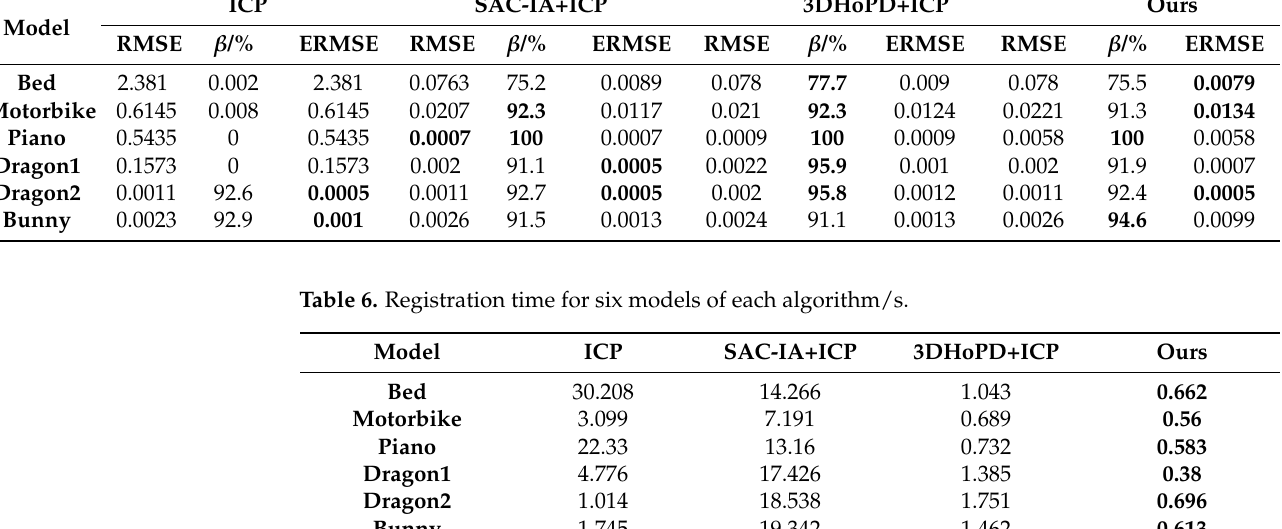
Table 6. Registration time for six models of each algorithm/s.